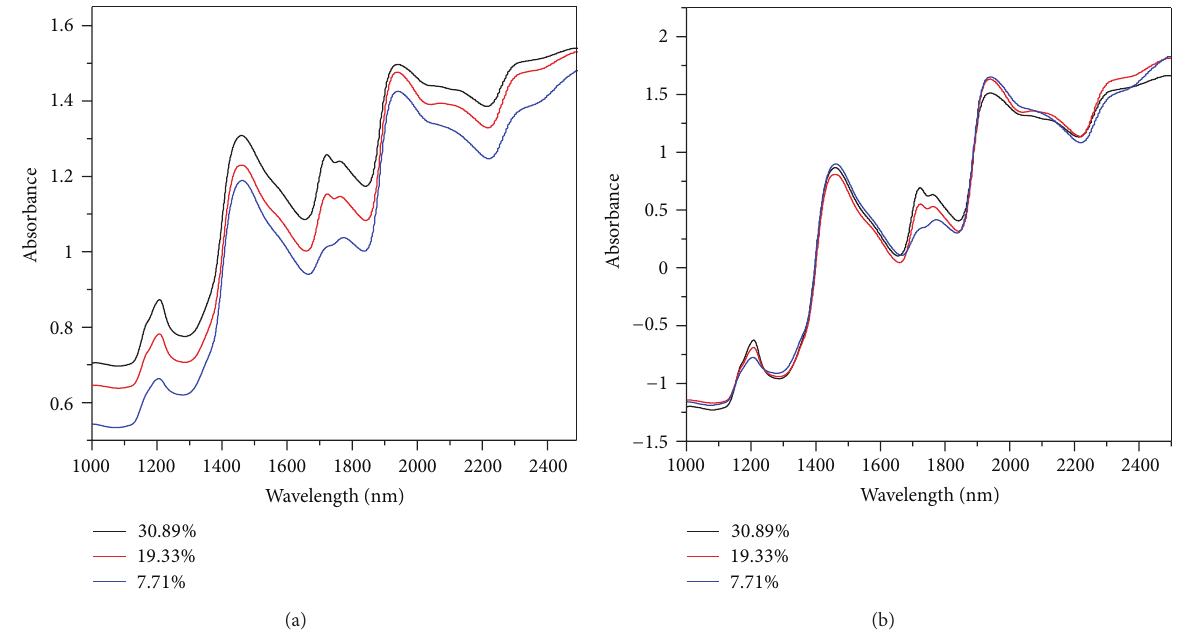
Figure 4: (a) Representative spectra of FBS with different fat contents and (b) their spectra after being treated with SNV.